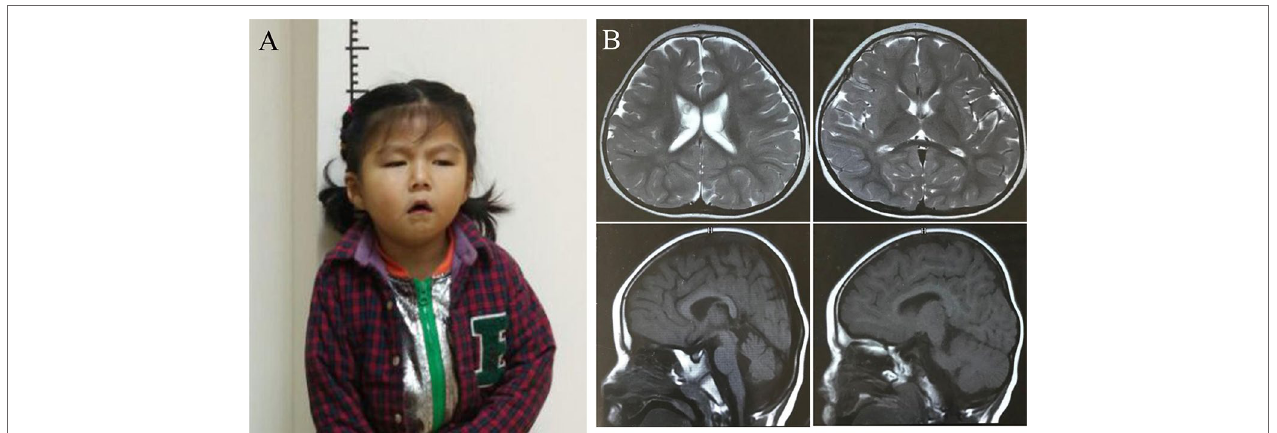
FIGURe 1 | Clinical and imaging features of the proband (A) The picture illustrates the facial dysmorphic features consisting of microcephaly, micrognathia, deep-set eyes, large ears, pointed nasal tip, and a downturned mouth. Written informed consent for publication of medical data and identifiable images was obtained from the parents of the patient. (B) . Brain MR images showed mild prominence of lateral ventricles, enlarged pericerebral spaces, high palate, delayed myelination, and a thin corpus callosum when the girl was at 4 years of life.